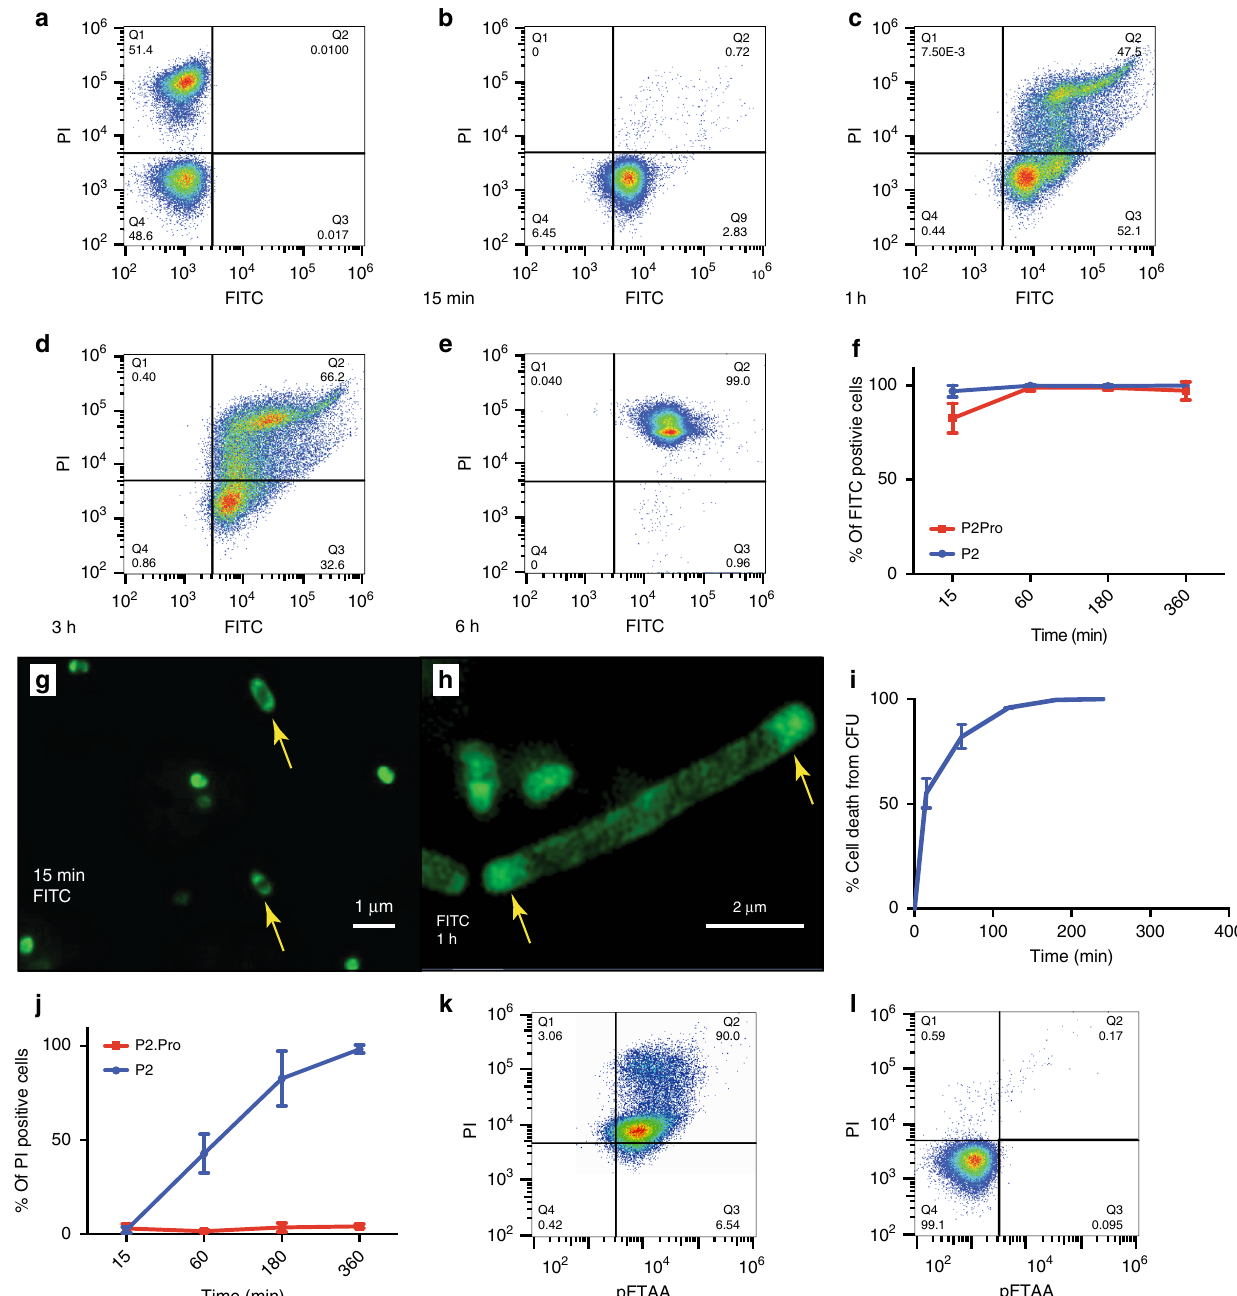
Fig. 2 Uptake and inclusion body formation. a – e Fluorescence-activated cell sorting (FACS) analysis of 40,000 E . coli O157: H7 cells, measuring FITC fl uorescence ( x -axis) and propidium iodide (PI) fl uorescence ( y -axis) of a untreated and heat-inactivated bacteria mixed at a ratio of 1:1 and b – e bacteria treated for 15 min ( b ), 1 h ( c ), 3 h ( d ), and 6 h ( e ) with FITC-labeled P2 at MIC concentration. f Average population sizes of FITC-positive cells treated with FITC-P2 or FITC-P2Pro from four independent experiments such as those shown in b – e . g Wide- fi eld structured illumination microscopy (SIM) image of E . coli treated with FITC-P2 for 15 min and h for 1 h at MIC concentration. i Time-dependent cell death following P2 treatment (1 x MIC) as % CFU/mL, in E . coli O157:H7. j Average population sizes of PI-positive cells (propidium iodide) from four independent FACS experiments such as those shown in a – e . k FACS analysis of 40,000 E . coli O157:H7 cells, measuring pFTAA fl uorescence ( x -axis) and PI fl uorescence ( y -axis) after 3 h of treatment with P2 at MIC concentration. l Same as h , but after treatment with 100 μ g/mL P2Pro samples by TEM con fi rmed the successful puri fi cation of these effect on colony formation, showing that the stress in this con- IBs (Fig. 3c). The composition of IBs was subsequently analyzed dition is not lethal. In order to understand why P2-induced IB by Coomassie-stained sodium dodecyl sulfate-polyacrylamide gel formation is irreversibly toxic, we compared the composition of electrophoresis (SDS-PAGE) (Fig. 3d). The overall pattern of IBs puri fi ed from E . coli O157:H7 cells treated with P2 at MIC Coomassie staining revealed that a large number of similar bac- concentration for 1 h with IBs puri fi ed from E . coli strain BL21 terial proteins are trapped in the IBs of both P2-treated E . coli overnight overexpressing p53CD. Inspection of the resulting NATURE COMMUNICATIONS | (2018) 9:866 | DOI: 10.1038/s41467-018-03131-0 |